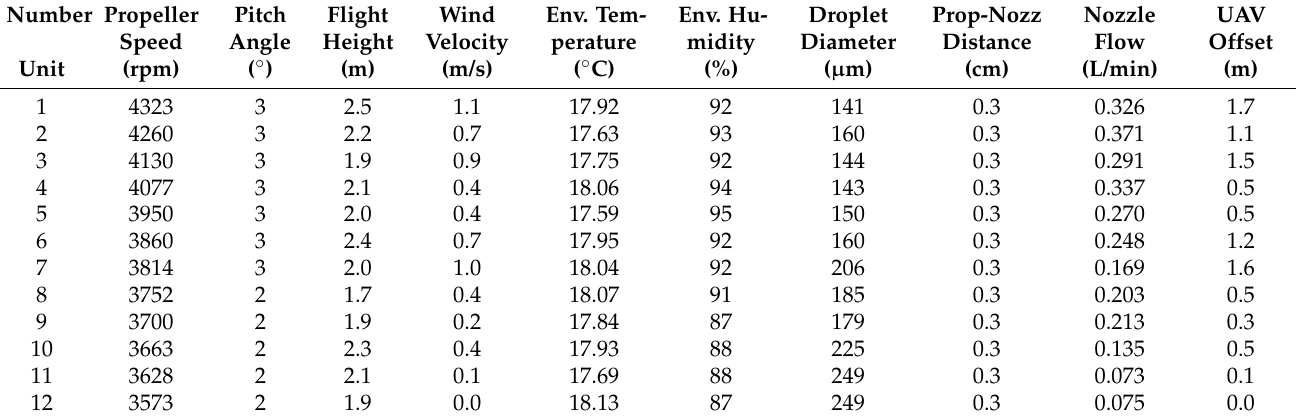
Table 5. State data sent to the server, and the center offset distance and effective deposition radius calculated in accordance with the data are returned from the server (a quarter of all